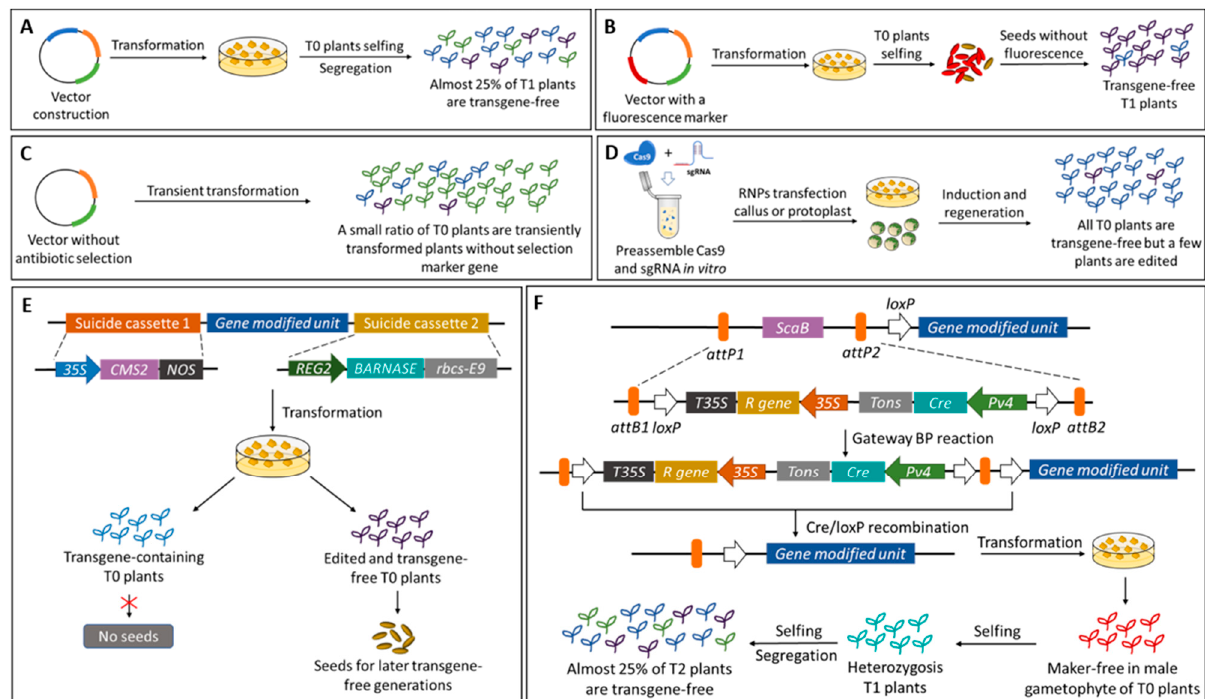
Figure 2. Strategies for producing transgene or marker-free crops that are rich in anthocyanins. ( A ) Eliminating foreign sequences through genetic segregation. T0 plants are usually heterozygous with transgenes. ( A ) A small number of T1 generation segregating from T0 plants will be transgene-free and the modified locus will be homozygous. ( B ) Fluorescence tag-assisted screening. By fusion, a fluorescence marker such as mCherry or GFP, seeds without foreign constructs, can be easily identified. ( C ) Using transient expressing editor without antibiotic selection. Without biotic selection, Agrobacterium -mediated transient expression of foreign genes but there are no transgenes integrated into the plant genome. ( D ) Preassembled CRISPR/Cas9 ribonucleoproteins (RNPs). Cas9 protein and sgRNA are preassembled in vitro , then the RNP complex is used to transfect callus or protoplast. Thus, all the T0 generation is transgene-free. ( E ) Using suicide Transgene Killer CRISPR (TKC) system. There are two suicide units assembled on the plasmid: the expression of a rice male gametophyte specific lethal gene CMS2 is driven by CaMV 35 S , and another lethal gene BARNASE is driven by a rice early embryo-specific promotor REG2 . In T0 plants, transgene-containing pollen and embryos are killed. ( F ) Multi-transgene stacking systems with a marker-free donor vector. In the donor vector plasmid, Cre recombinase is driven by a pollen-specific promotor Pv4 . The Cre and resistance gene ( R gene ) cassette is assembled into the transgene plasmid by Gateway BP reaction. Then Cre expression in pollen mediates the self-elimination of Cre and R gene cassette based on the Cre/loxP recombination. Marker-free progeny can be screened by genetic segregation in the T2 generation.